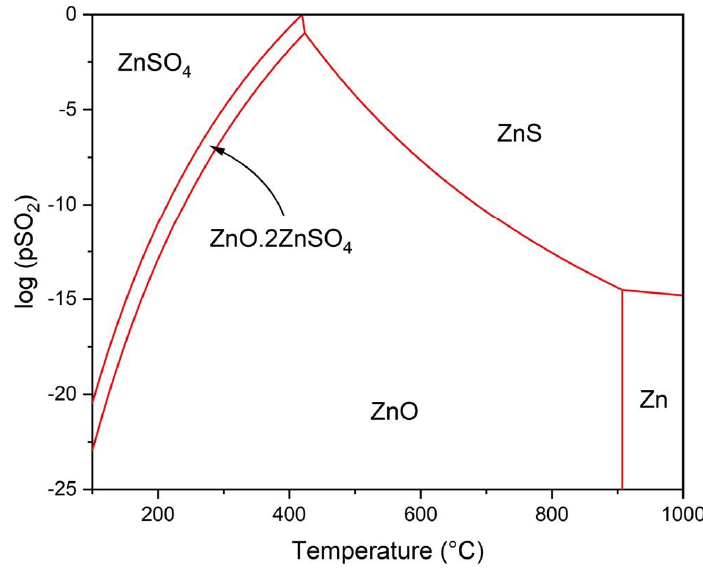
Energies 2022 , 15 , x FOR PEER REVIEW Figure 3. Predominance diagram for Zn-S-O system as a function of temperature and log pSO 2 .